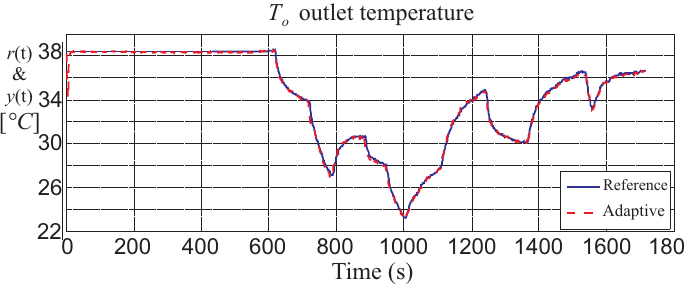
Figure 11. TU module outlet air temperature compensated by the adaptive regulator.